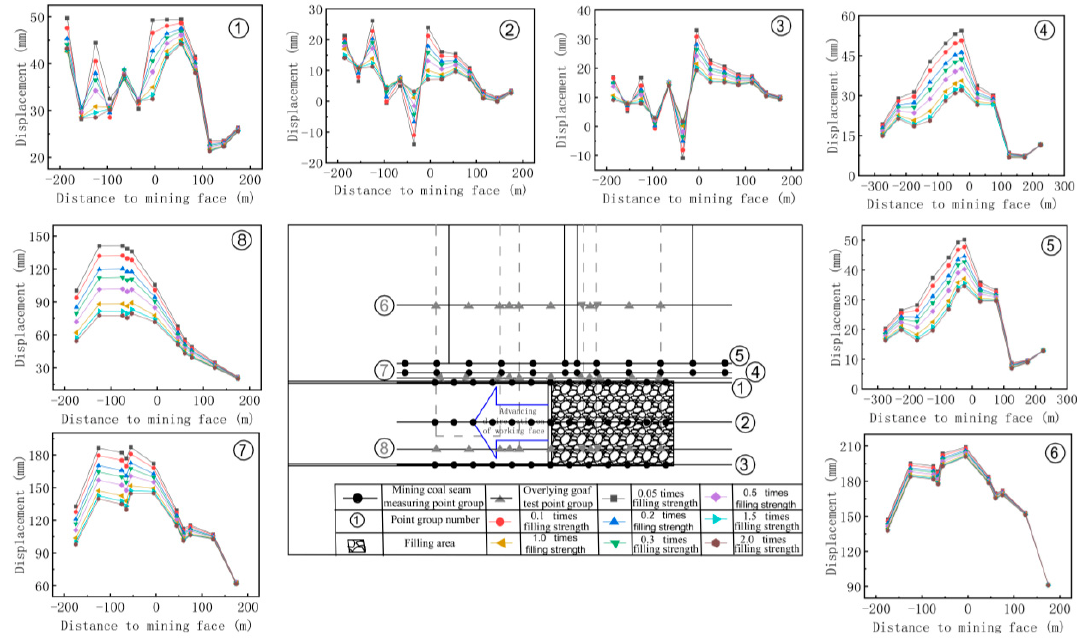
Figure A2. Movement characteristics of coal and rock strata (180 m).